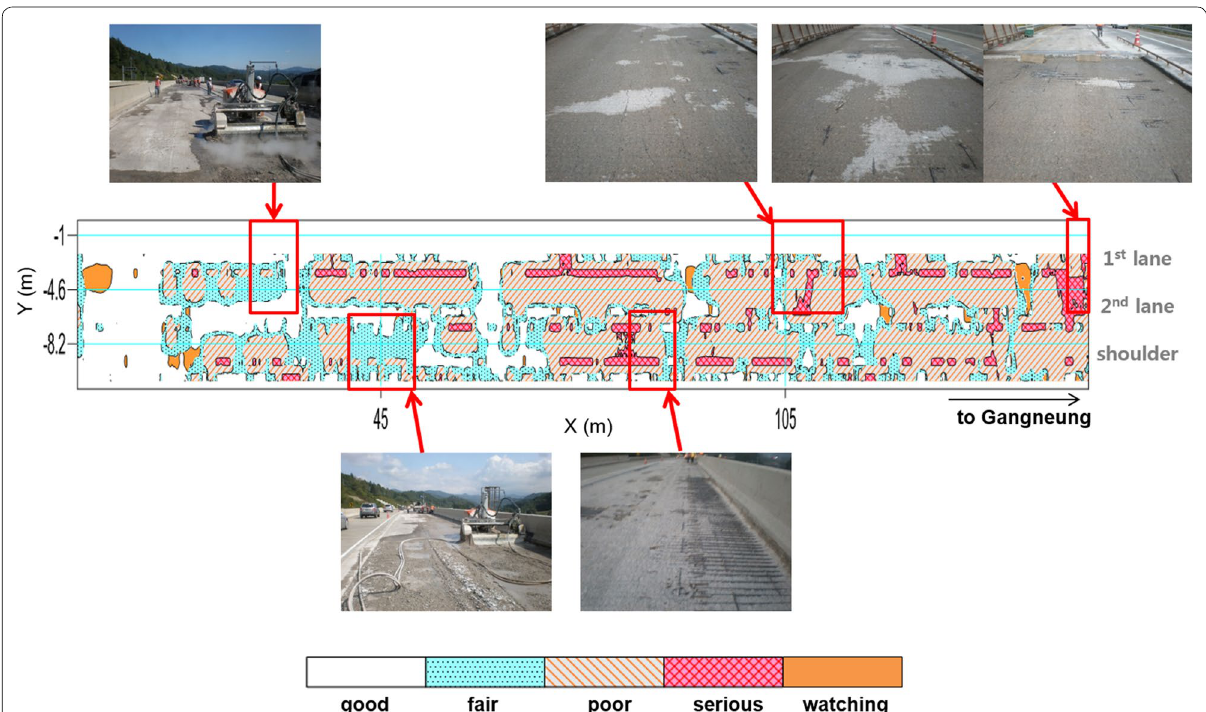
Fig. 16 Condition map based on both relative permittivity of concrete and depth‑corrected attenuation at top rebar with images of the internal concrete of bridge deck during repairing